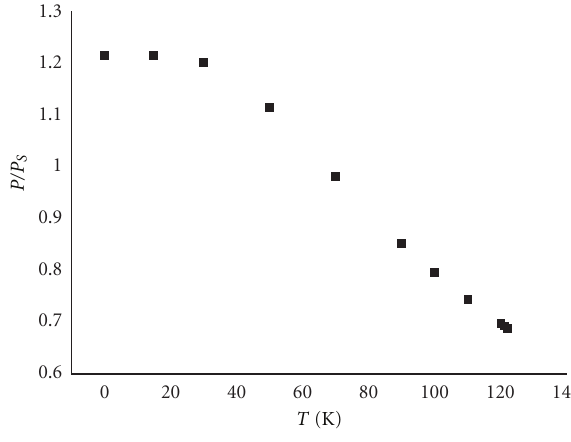
Figure 1: Ratio of the spontaneous polarization P/P S with respect to the saturated polarization P S which was calculated from (9) and (10) as a function of temperature at zero pressure in the ferroelectric phase ( T < T C ) for KDP.